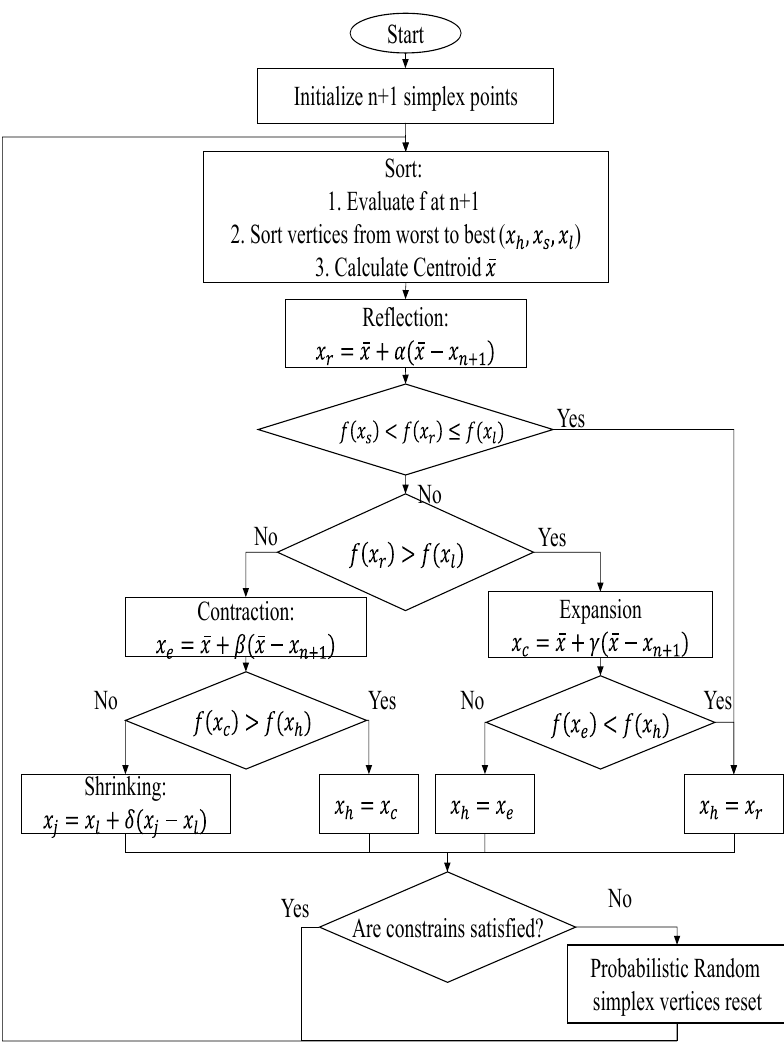
Figure 2. Globalized constrained Nelder–Mead algorithm